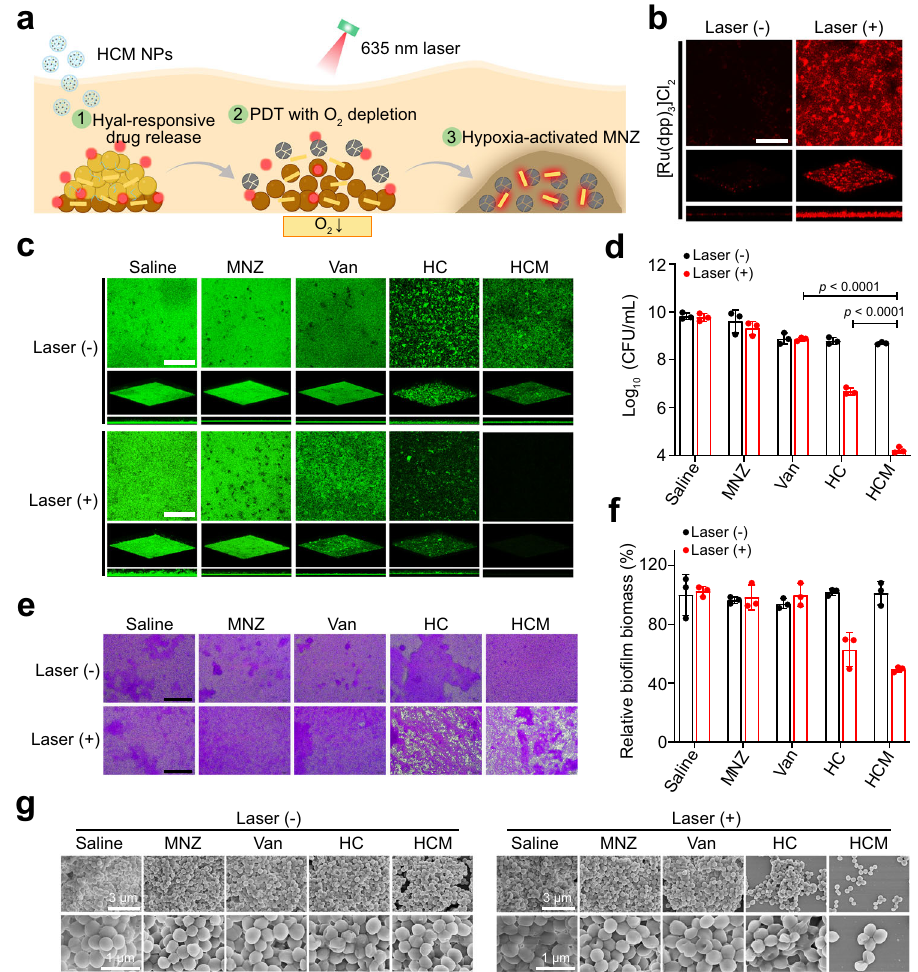
Fig. 4 PDT-activated chemotherapy of MRSA bio fi lms by hypoxia potentiation. a Schematic illustration of the PDT-induced hypoxia and subsequent activation of MNZ for enhanced anti-bio fi lm treatment by HCM NPs. b Three-dimensional (3D) CLSM images of [Ru(dpp) 3 ]Cl 2 stained MRSA bio fi lms with or without PDT (635 nm, 20 mW/cm 2 , 30 min) by HCM NPs. Scale bar is 200 μ m. Size of CLSM images is 630 μ m × 630 μ m. c 3D CLSM images of MRSA bio fi lms stained by Calcein-AM (green) after various treatments. Size of CLSM images is 630 μ m × 630 μ m. Scale bar is 200 μ m. d Numbers of viable MRSA within bio fi lms after various treatments ( n = 3 biologically independent samples; mean ± SD). Statistical signi fi cance was analyzed via two- way ANOVA test with a Tukey post-hoc test. e Micrographs of MRSA bio fi lms stained by crystal violet after various treatments. Scale bar is 200 μ m. f Relative bio fi lm biomass of MRSA bio fi lms after various treatments ( n = 3 biologically independent samples; mean ± SD). g Scanning electron microscopy (SEM) images of MRSA bio fi lms after various treatments. Three independent experiments were performed and representative results are shown in b , c , e , and g . Source data are provided as a Source Data fi